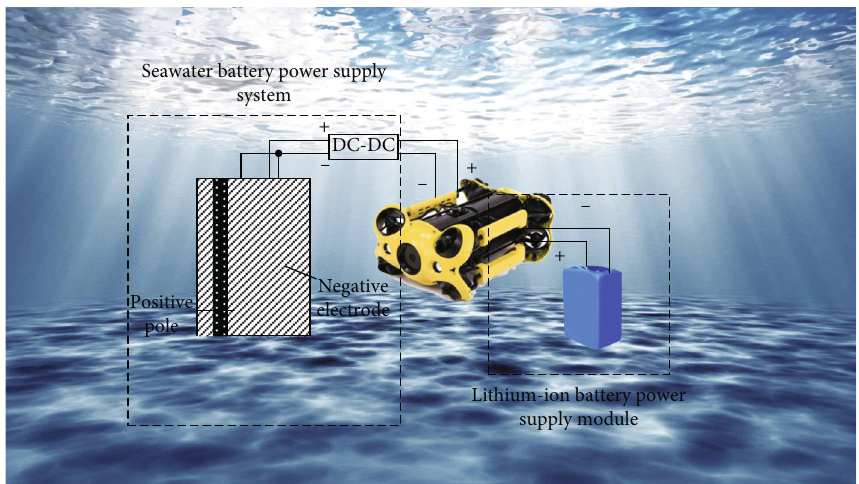
Figure 1: Energy supply system for autonomous underwater observation vehicles.